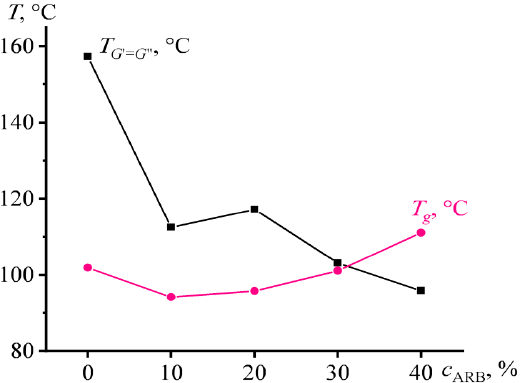
Figure 3. Temperature dependences of ( a ) storage and loss moduli and ( b ) loss tangent for triple mixtures containing different concentration of asphaltene/resin blend (ARB) and an equal ratio between styrene-isoprene-styrene triblock copolymer (SIS) and naphthenic oil.